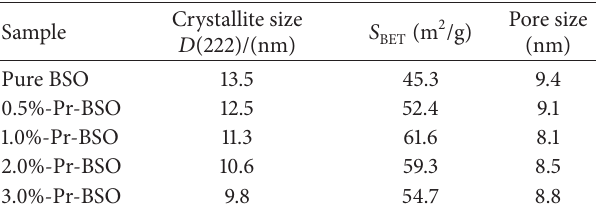
Table 1: Crystallite size, BET surface areas, and pore size of different